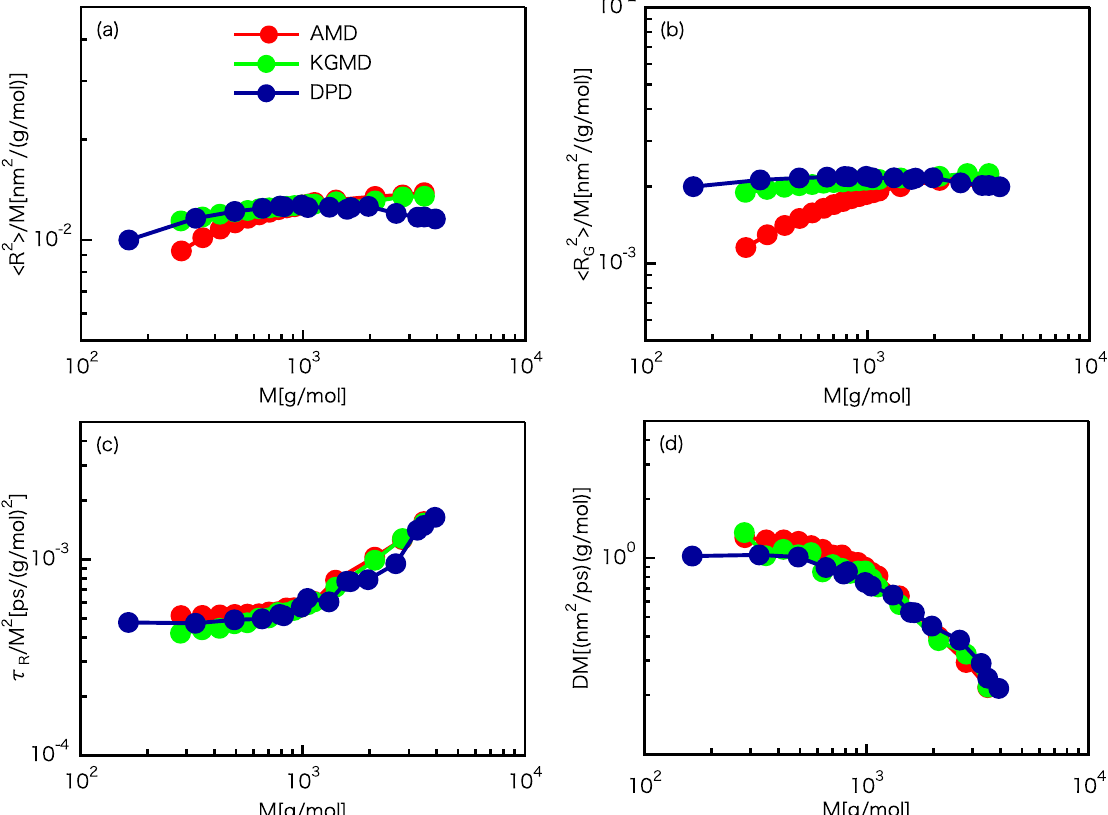
Figure 1. Comparison of the scaling laws for the UA PE model and rescaled CG models. ( a ) (cid:104) R 2 (cid:105) – M (cid:105) – M scaling law. ( c ) τ scaling law. ( b ) (cid:104) R 2 R – M scaling law. ( d ) D – M scaling G